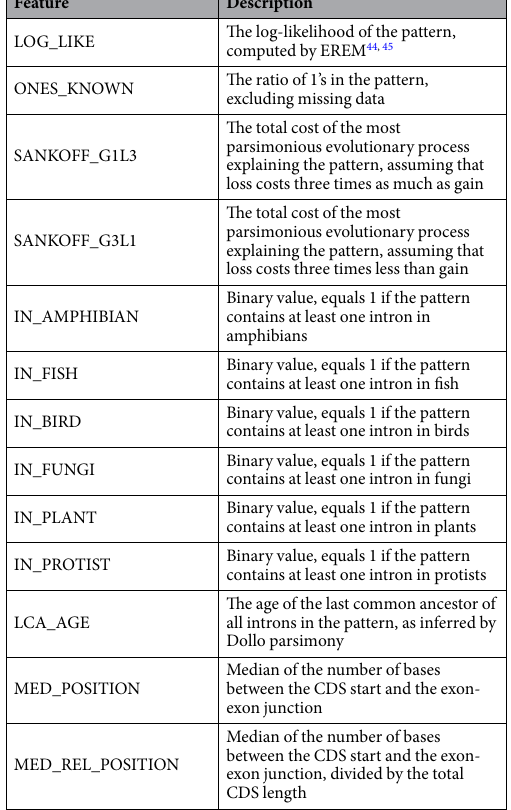
Table 2. Description of the pattern-characterizing features.